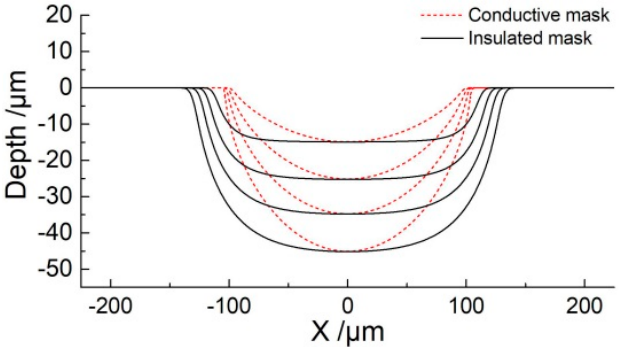
Figure 5. Cross-section profiles of micro-grooves with different masks.